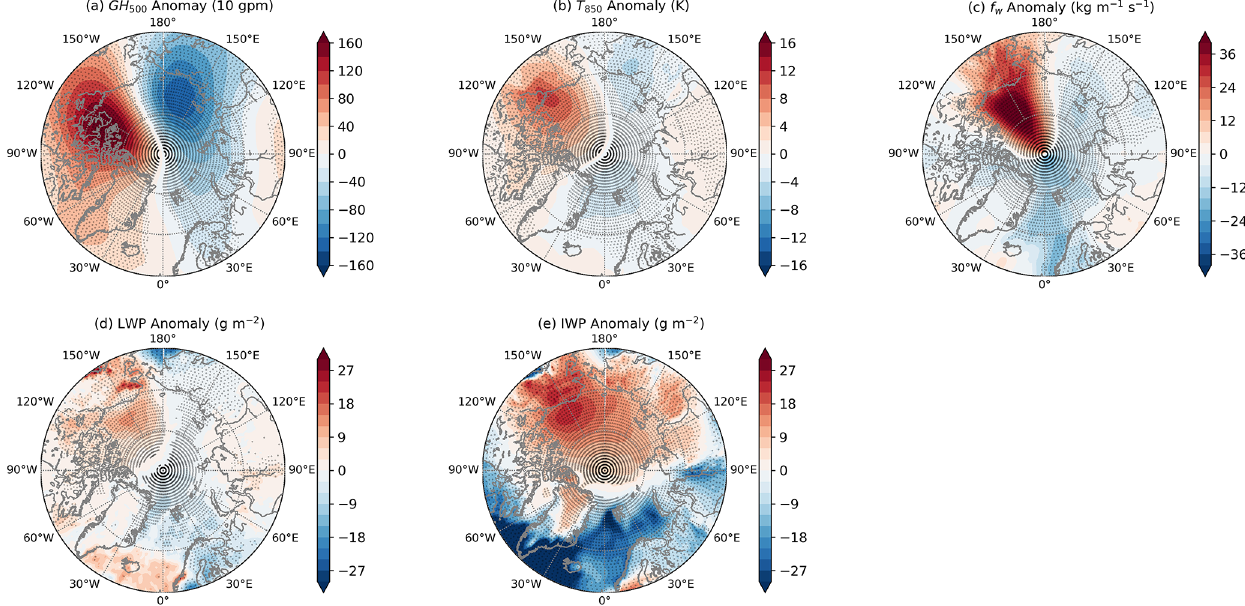
Figure 4. Composite ERA5 anomalies of (a) 500hPa GH (10gpm), (b) 850hPa temperature (K), (c) northward water-vapor flux (kgm − 1 s − 1 ), (d) liquid water path (gm − 2 ), and (e) ice water path for all EMIs over the Beaufort Sea, during 1979–2018 winters. The stippling indicates statistical significance at the p < 0 . 01 level from a Student’s t